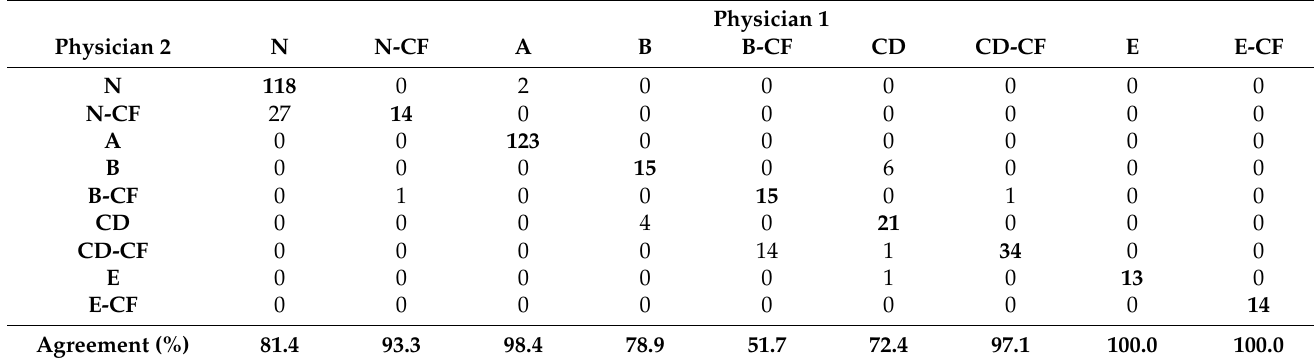
Table 3. Comparison of waveform categorization between the two trained vascular medicine physicians according to the simplified Saint-Bonnet